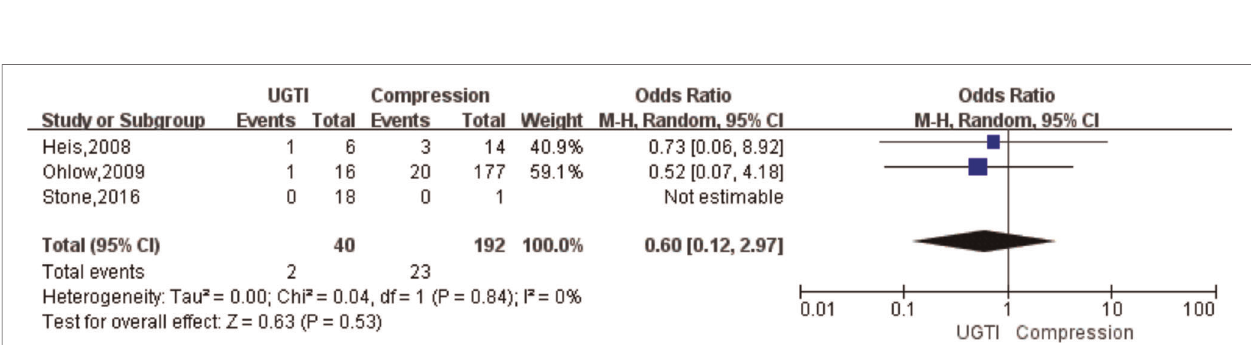
FIGURE 5 | Forest plot showing the pooled odds ratio for failure rate of subgroup analysis about compression and UGTI group.